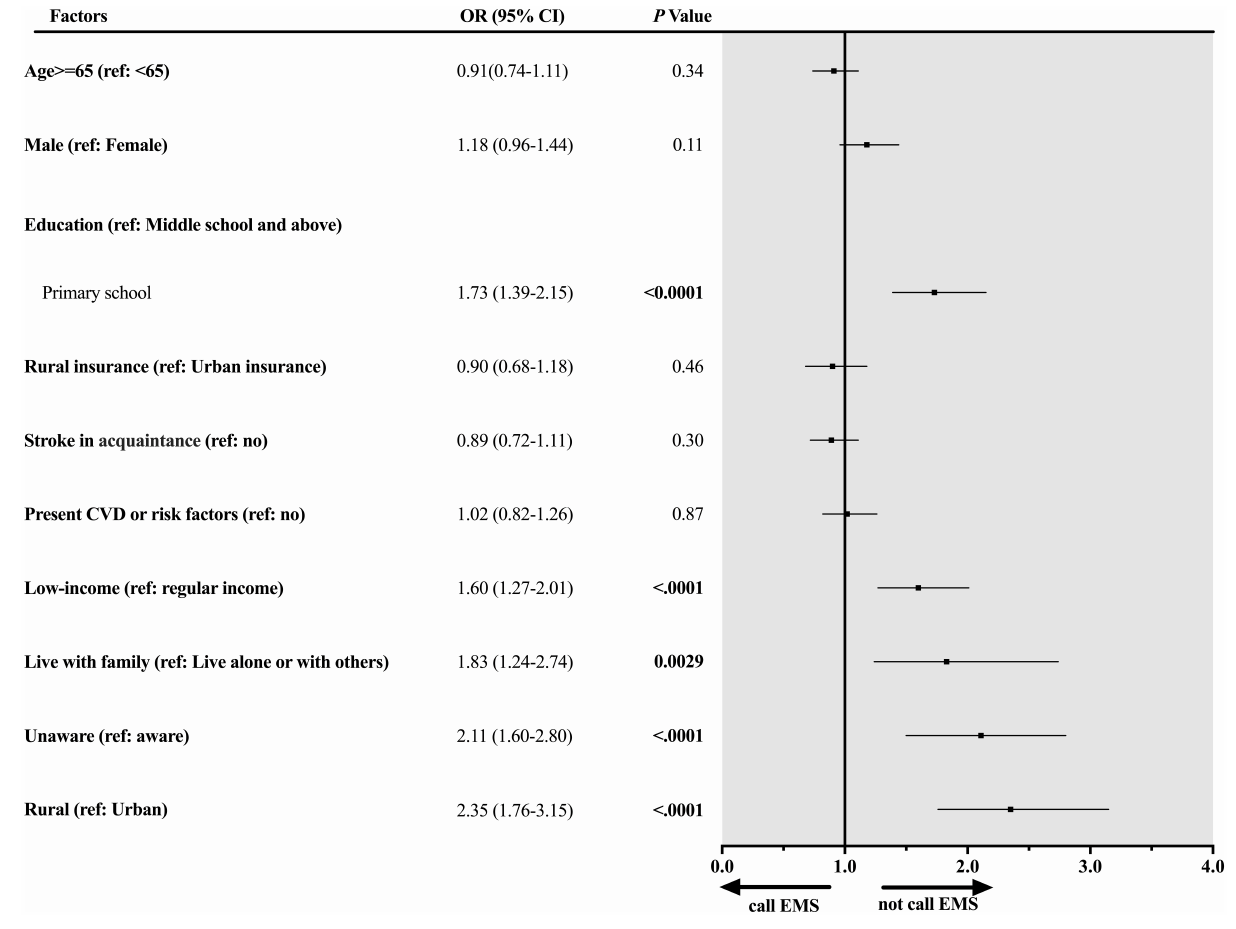
only slightly lower than that in the general population